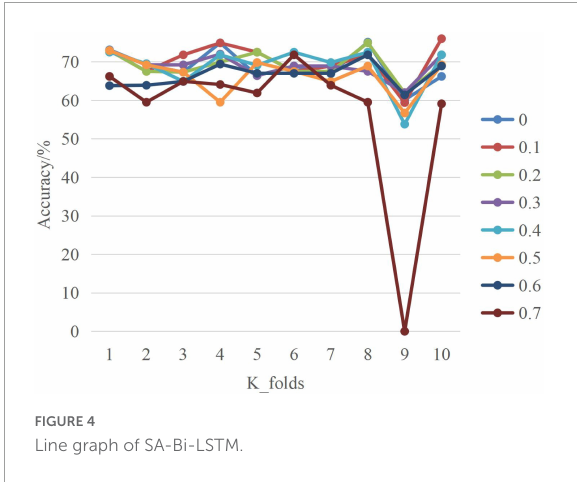
TABLE 4 Accuracy comparison with different models.